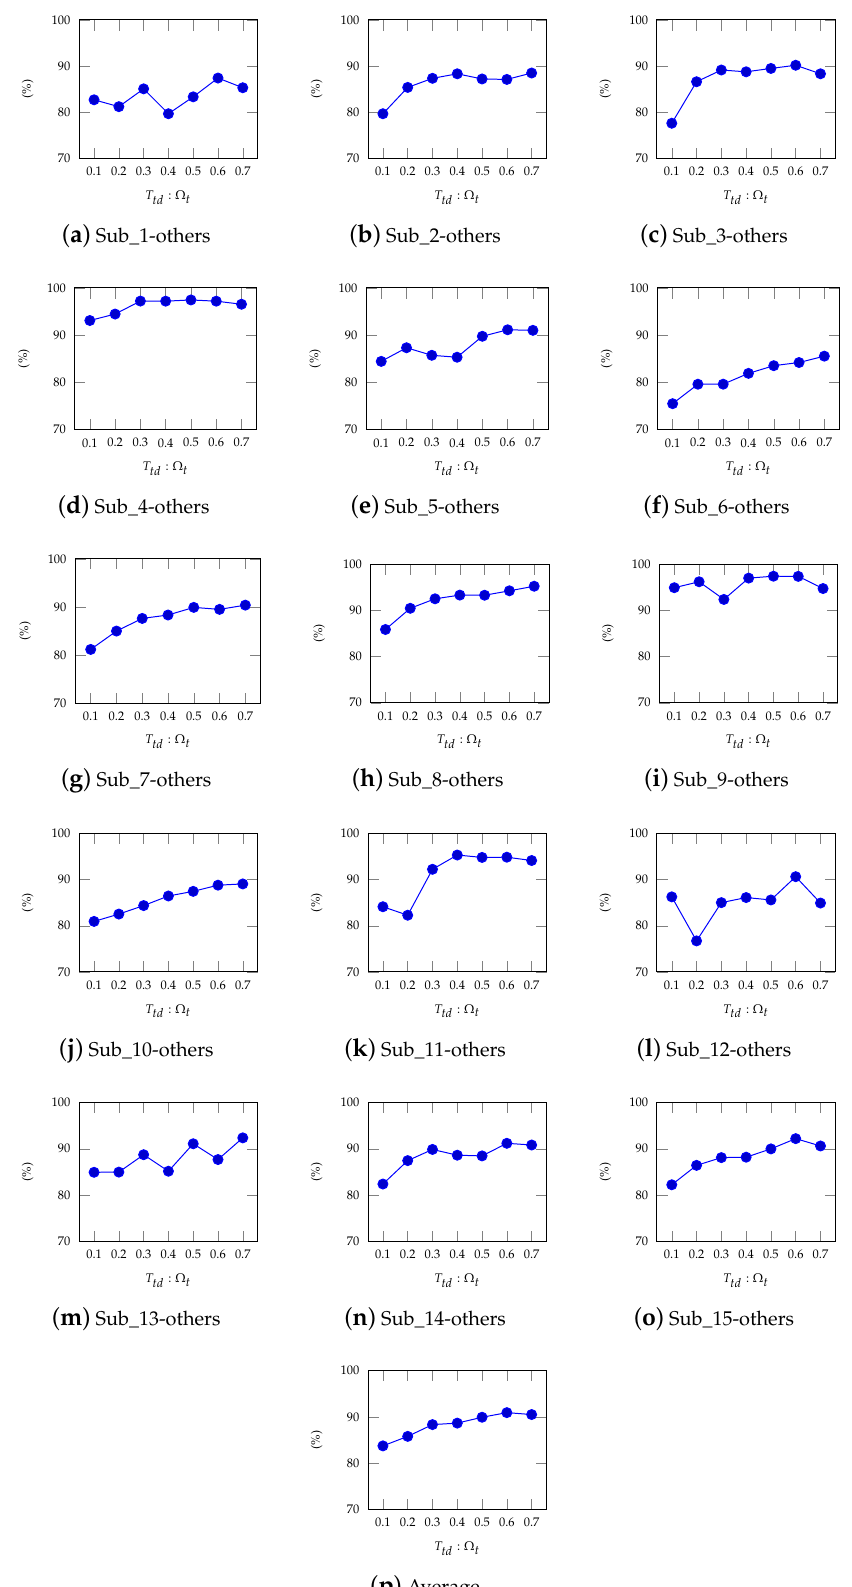
Figure 10. The accuracy of InstanceEasyTL with different T td : Ω t , where Sub_i-others (i = 1, 2, ..., 15) has the same meaning as in Figure 9. We also calculate the average accuracy of